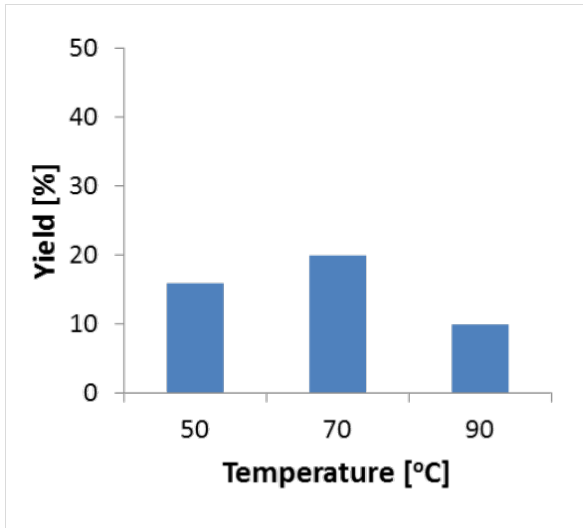
Figure 5: Effect of temperature on product yield. Reaction conditions: Reaction volume (0.250 mL), TA (1.1 mg, specific activity – 0.052 U/mg), flow rate (25 μ L/min). Samples were taken after 30 minutes at the indicated temperature.